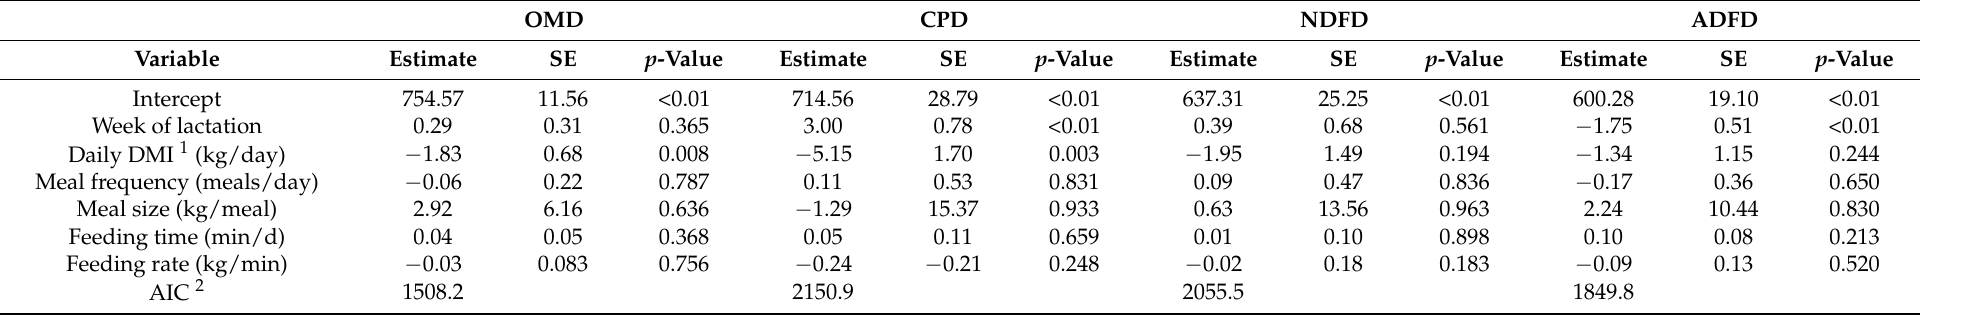
Table 6. Influence of week of lactation, dry matter intake and variables of intake behavior on digestibility of OM, CP, NDF and ADF during early lactation in dairy cows, estimated by linear mixed model (LMM) procedure (n =